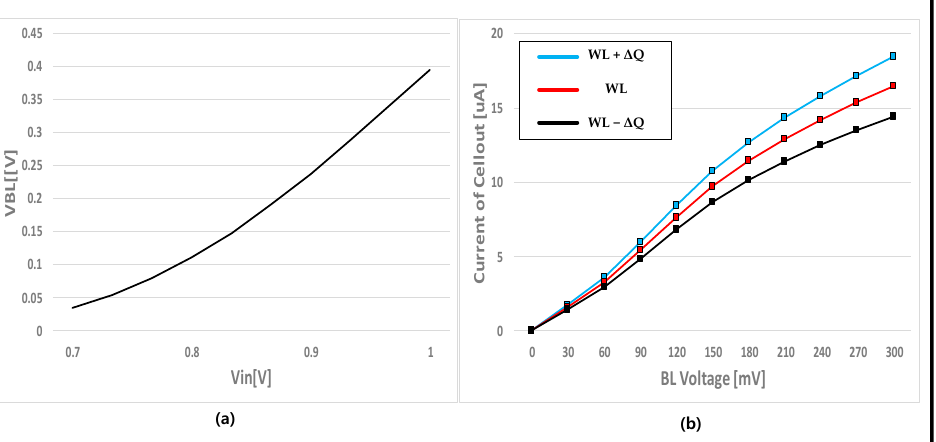
Figure 7. ( a ) Voltage transfer curve of the pre-distorted BL driver and ( b ) the CTT cell current.